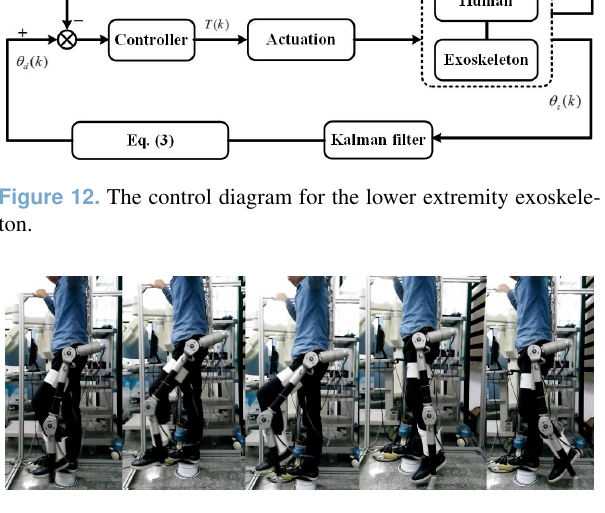
Figure 13. Experiments wearing the lower extremity for the swing